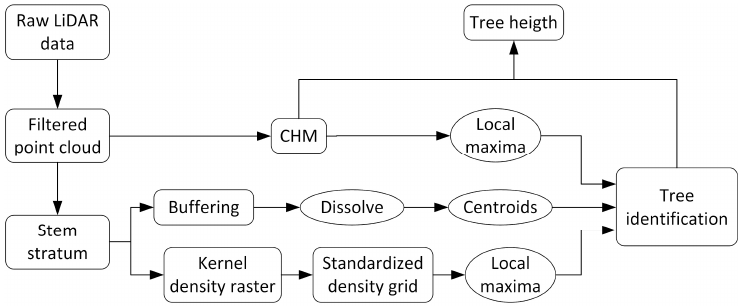
Figure 2. Flow chart for the three methods of individual tree detection.